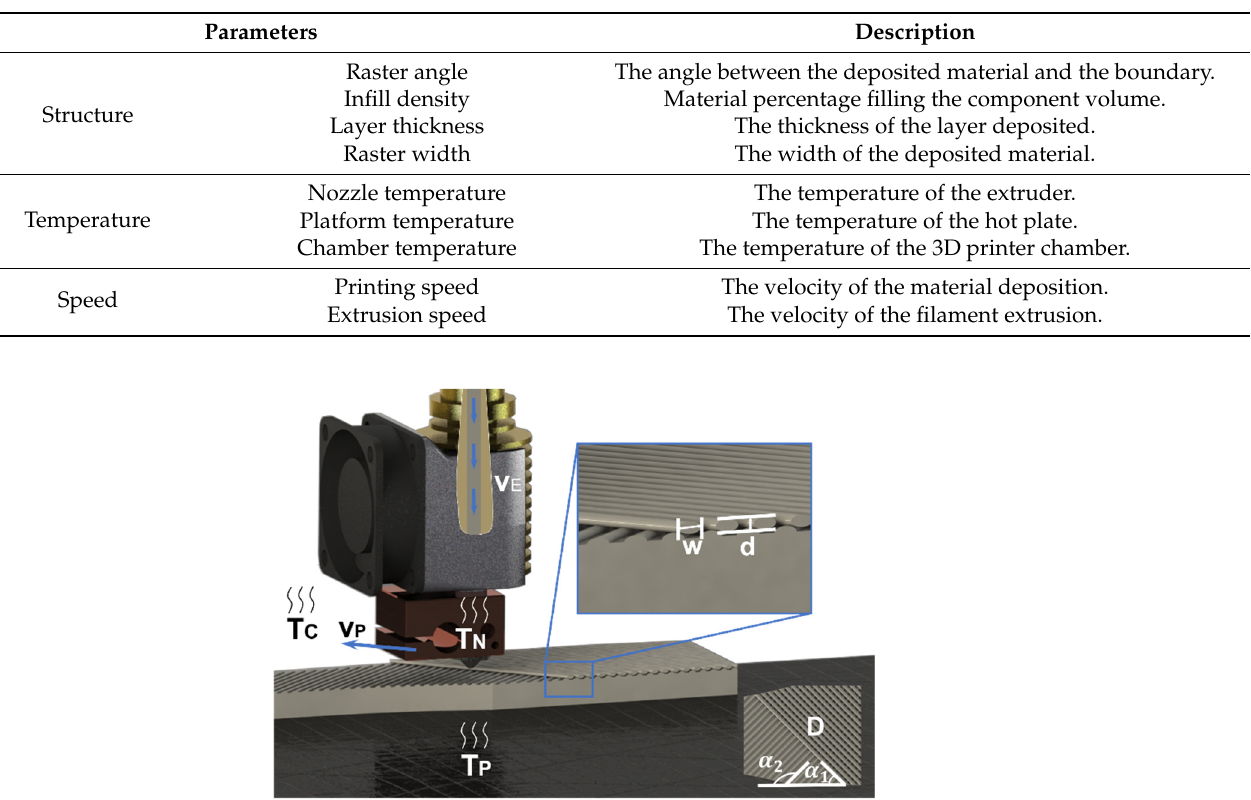
Table 2. The definition of various parameters.